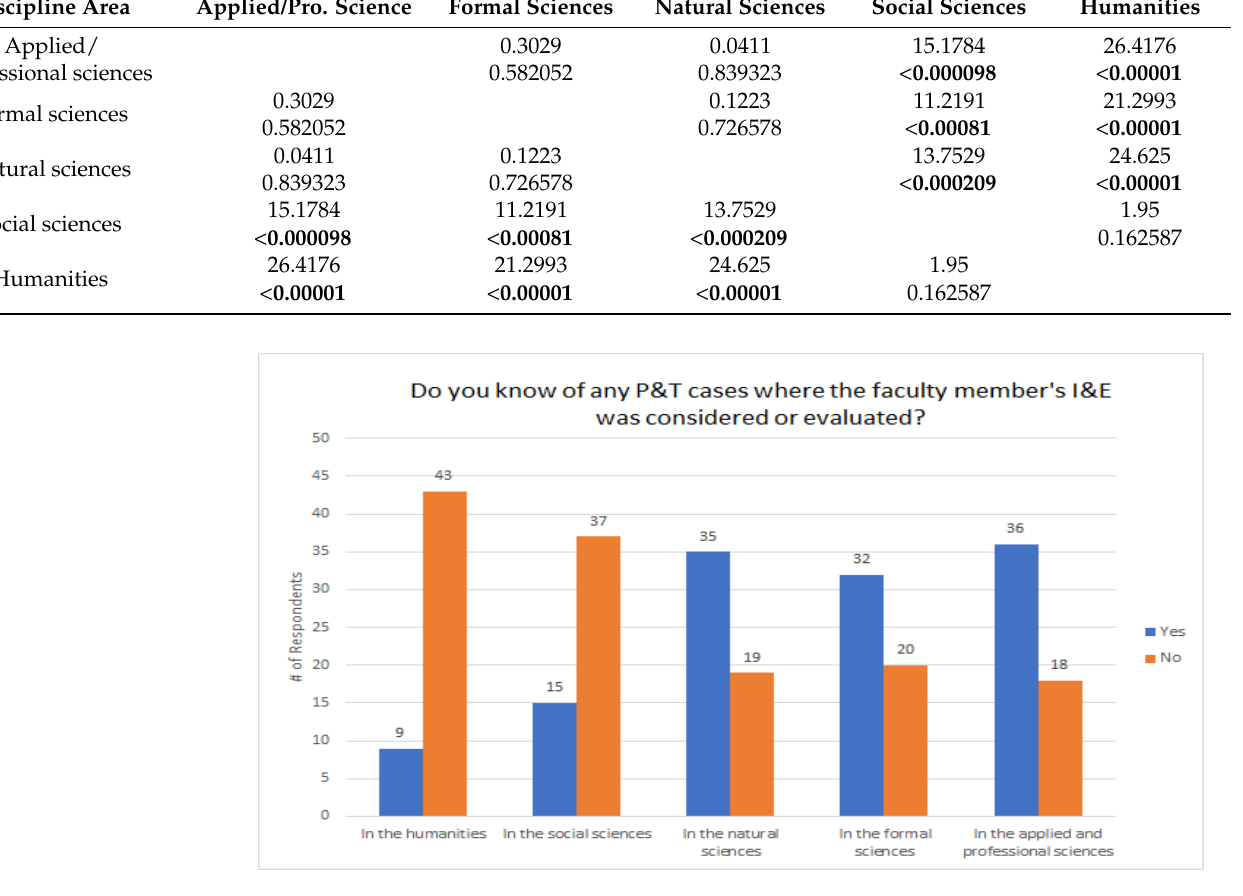
Figure 12. Comparison of I&E considerations in P&T processes across disciplines at respondents’ institutions.